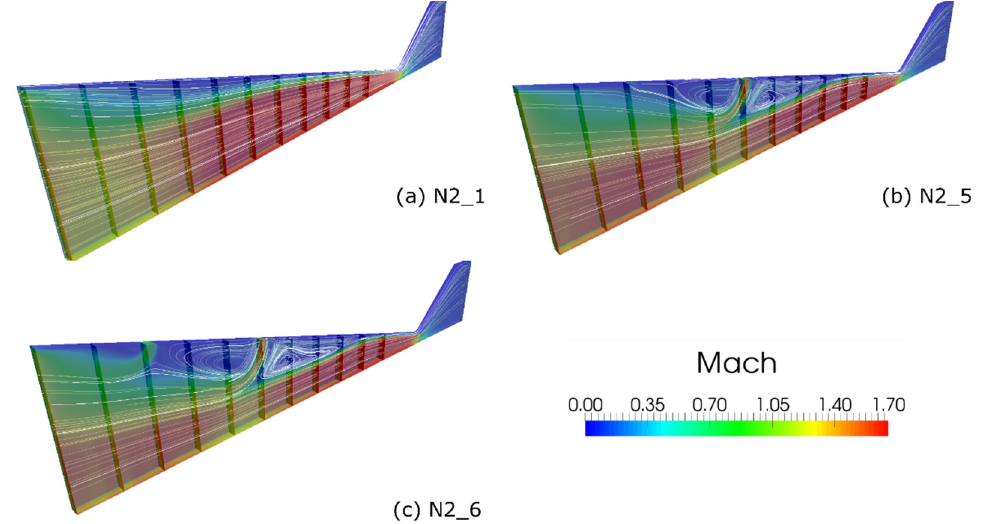
Figure 10. 3D representation of the water vapor flow into the micro-nozzle through contour plot of the Mach number in combination with streamline visualization: ( a ) test case N2_1 (baseline); ( b ) test case N2_5 (additional mass flow rate, jet 1 = ON, jet 2 = OFF); ( c ) test case N2_6 (additional mass flow rate, jet 1 = ON, jet 2 = ON).